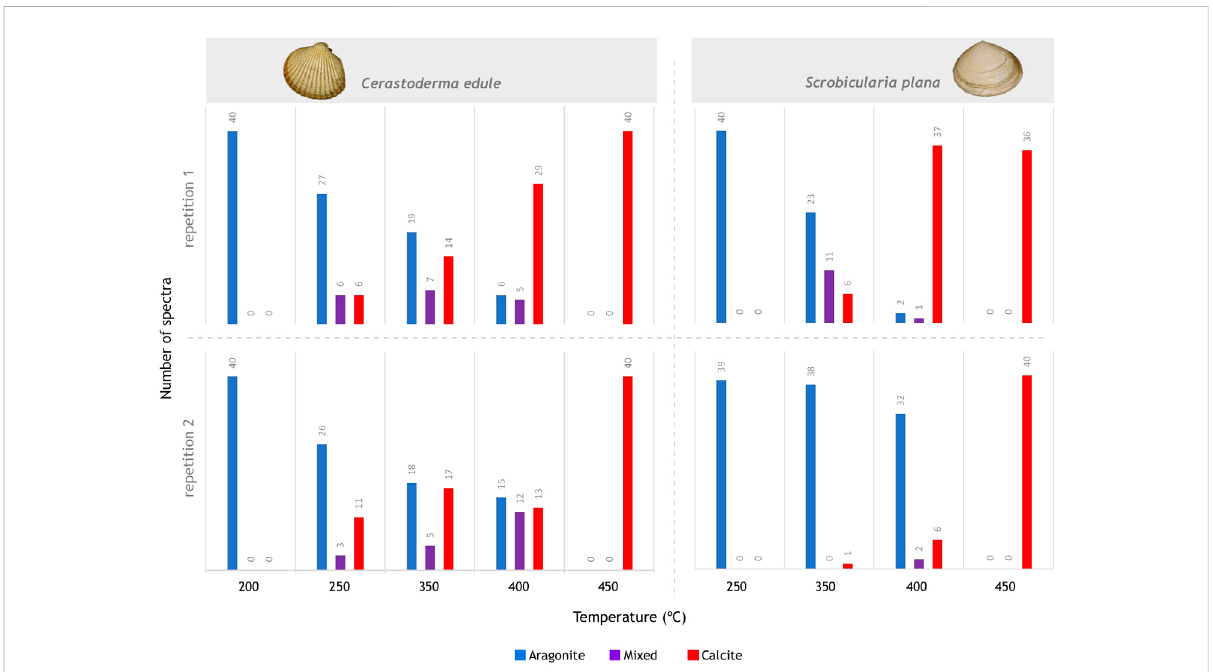
FIGURE 3 Aragonite-calcite conversion in the 18 experimentally heated shells; each individualized graph represents a single specimen of the two repetitions at each temperature; note the gradual conversion observed in Cerastoderma edule and the abrupt conversion in Scrobicularia plana . Shell species image credits: Natural History Museum Rotterdam, adapted from original fi le at WoRMS Database (https://www.marinespecies.org/ index.php) under a CC BY-NC-SA license.